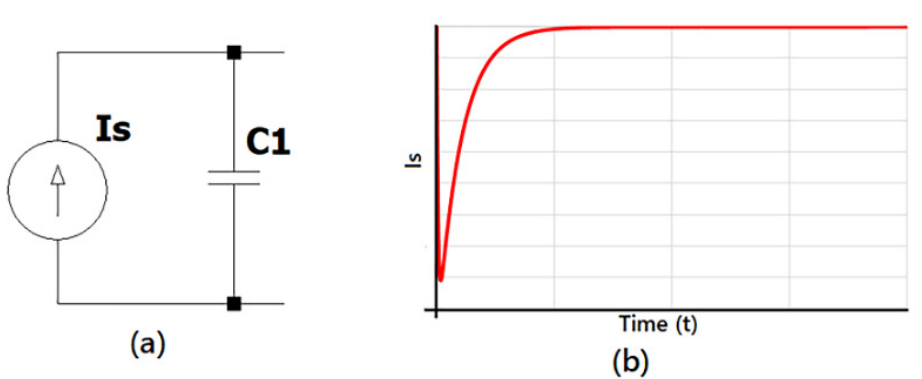
Figure 10. ( a ) Equivalent circuit of SiPM. ( b ) Current pulse generated from scintillation.